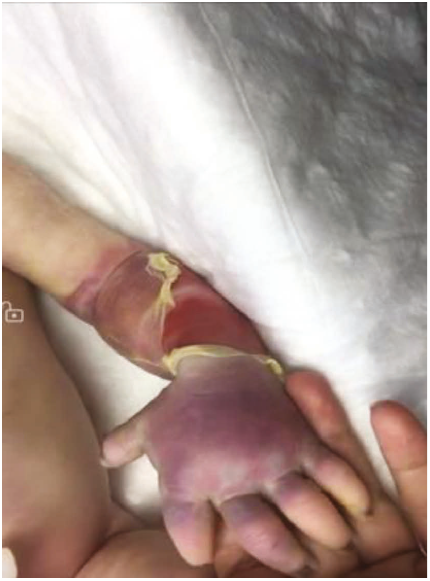
Figure 1: A photograph that shows swelling, cyanosis, and skin maceration in the left forearm and hand of our